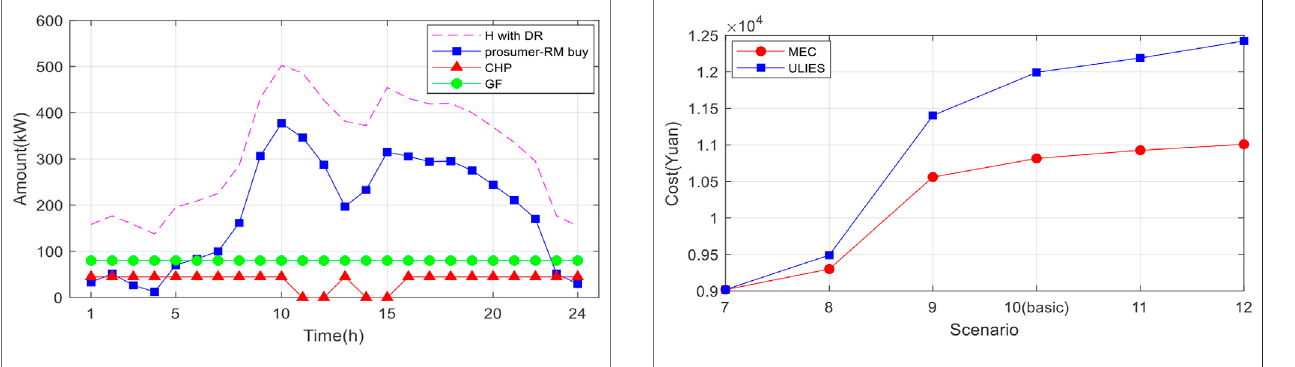
FIGURE 9 | Impacts of retail price differences in RM.